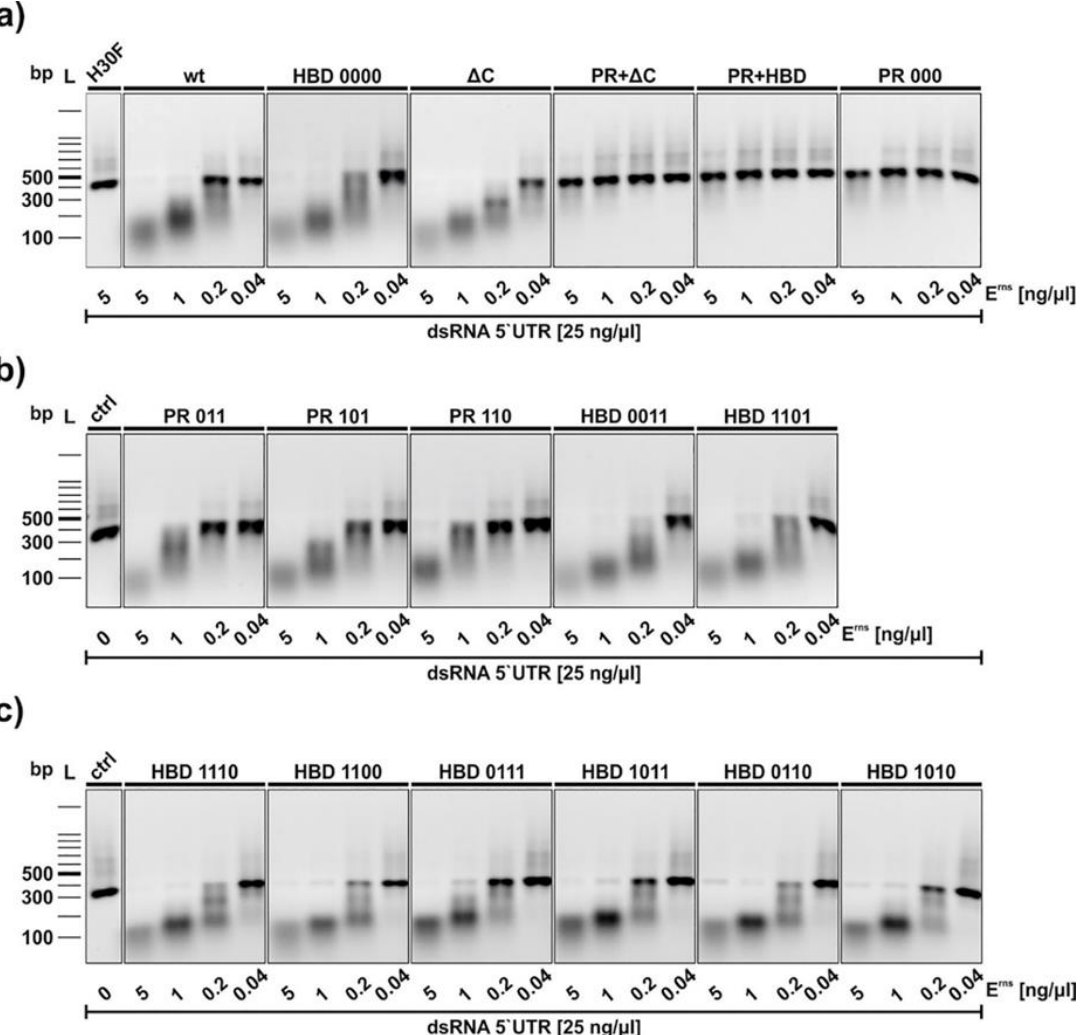
Figure 3. RNase activity assay of wt and mutant E rns . Constructs were incubated with an in vitro-transcribed 300 bp dsRNA of the 5 ′ -UTR of the BVDV strain Ncp7. Panel ( a ) Analysis of wt E rns and its full mutants. The terms PR and HBD in the lanes “PR + ΔC” and “PR + HBD” in this panel indicate the full mutants, i.e., PR 000 and HBD 0000. H30F represents the RNase-inactive mutant of E rns used at the highest concentration, whereas the control (ctrl) in panels ( b , c ) indicates dsRNA incubated in the absence of any E rns protein. Panels b and c contains PR- and HBD mutants with one or two of the lysines (code “1) replaced by alanine (code “0”). The concentrations of dsRNA and the proteins used are indicated. After one hour at 37 °C, the samples as well as a 100 bp DNA size marker were separated on a 1% agarose gel containing ethidium bromide. Bands were visualized by UV light. One representative experiment out of three is shown.